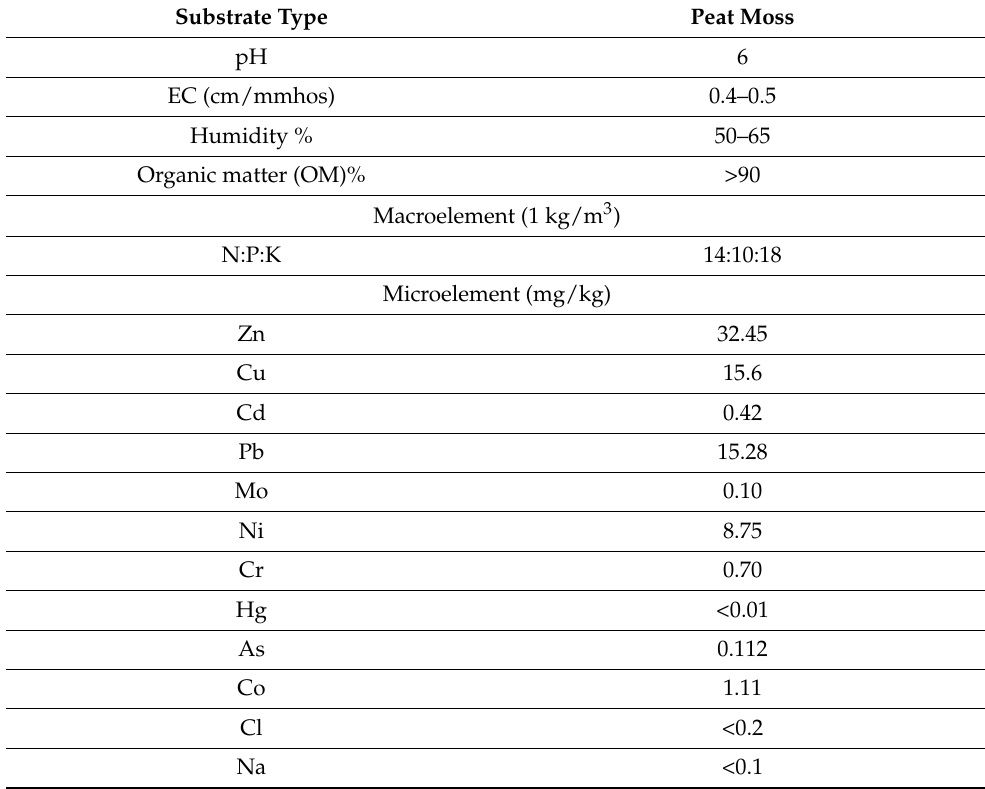
Table 1. Klassmann TS3 Baltic peat chemical